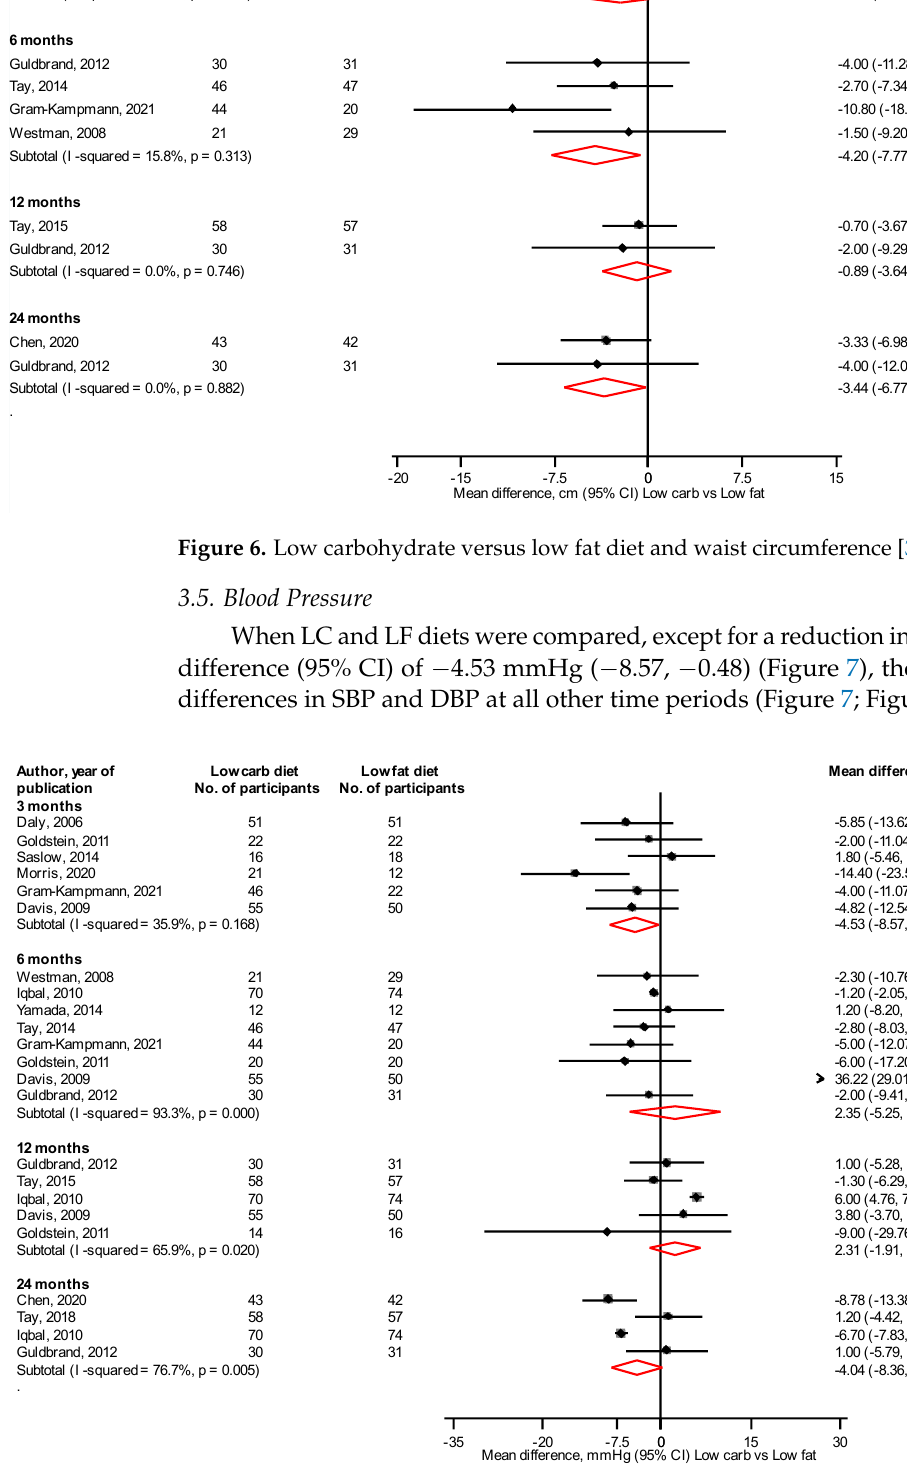
Figure 7. Low carbohydrate versus low fat diet and systolic blood pressure [31 – 36,39,43,48 –